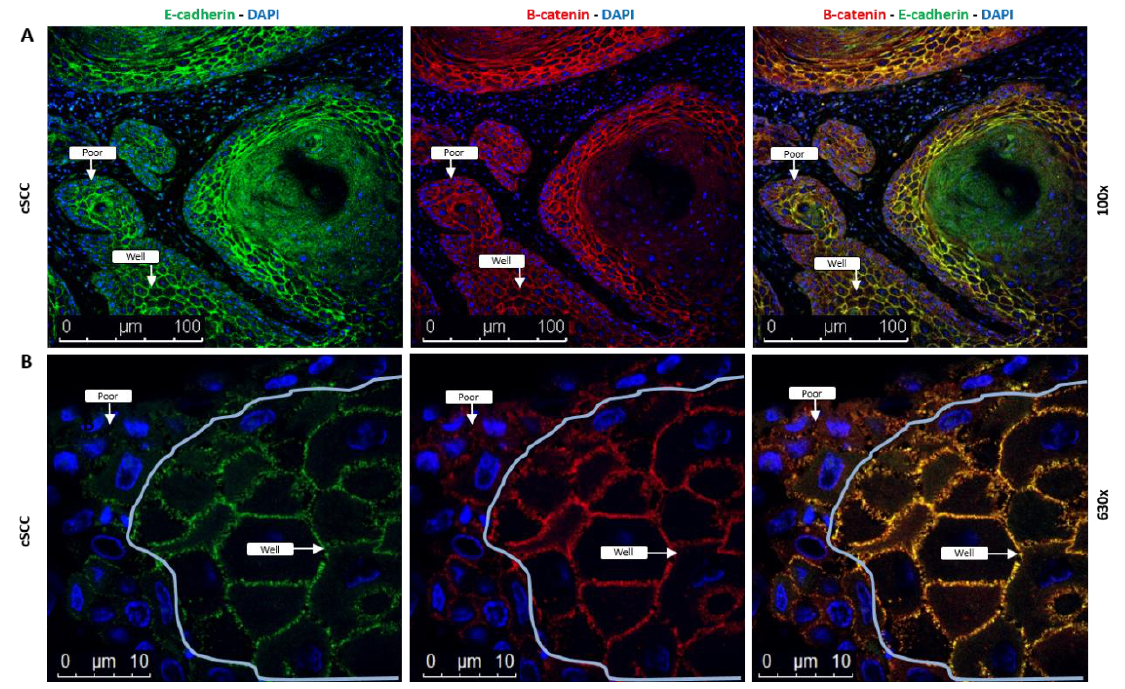
Figure 5. Immunofluorescence staining of cSCC tissues for E-cadherin (green) and β -catenin (red). The well-differentiated cancer cells (well) show that E-cadherin and β -catenin appear to be coex- pressed (yellow) with loss of this coexpression in the poorly differentiated cells (poor) along the leading edges of the tumors. Images in Panel A (top) were taken at 100× magnification and show the well-differentiated cells (well) central to the poorly differentiated cells within each tumor mass. Images in Panel B (bottom) were taken at 630× magnification; the blue solid line delineates the poorly differentiated cells from the well-differentiated cells within a tumor mass, with the cells to the right being toward the center of the tumor mass.